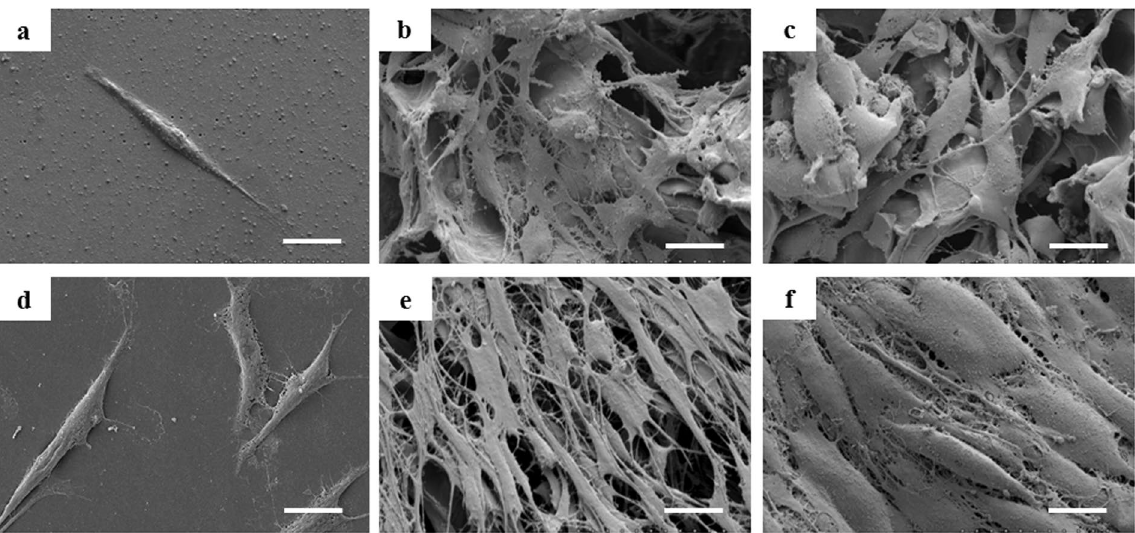
Figure 4. SEM images of BMSCs grown in static-2D group after 3 days ( a ), 7 days ( d ), static-3D group after 3 days ( b ), 7 days ( e ), and RCCS-3D group after 3 days ( c ), 7 days ( f ). Scale bar = 20 μ